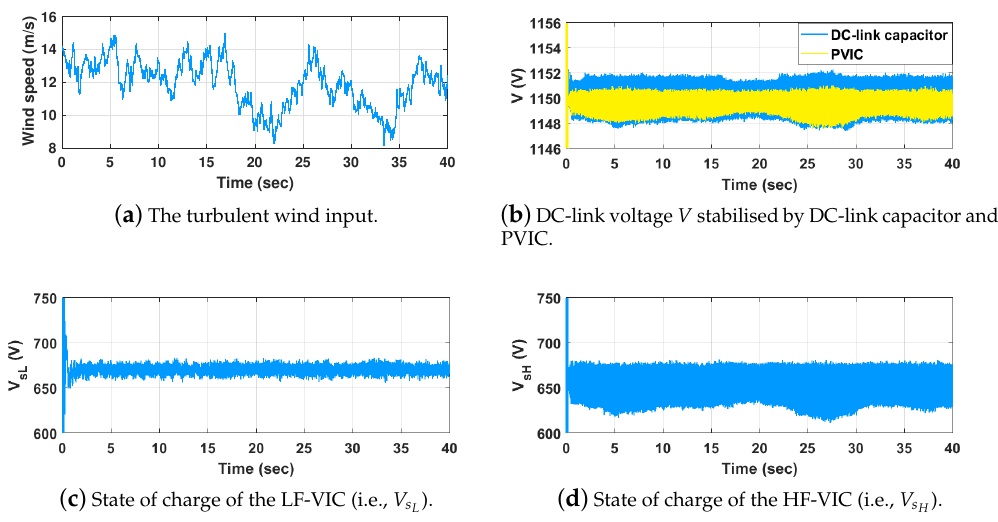
Figure 6. Wind input and performances of PVIC under normal grid operation.